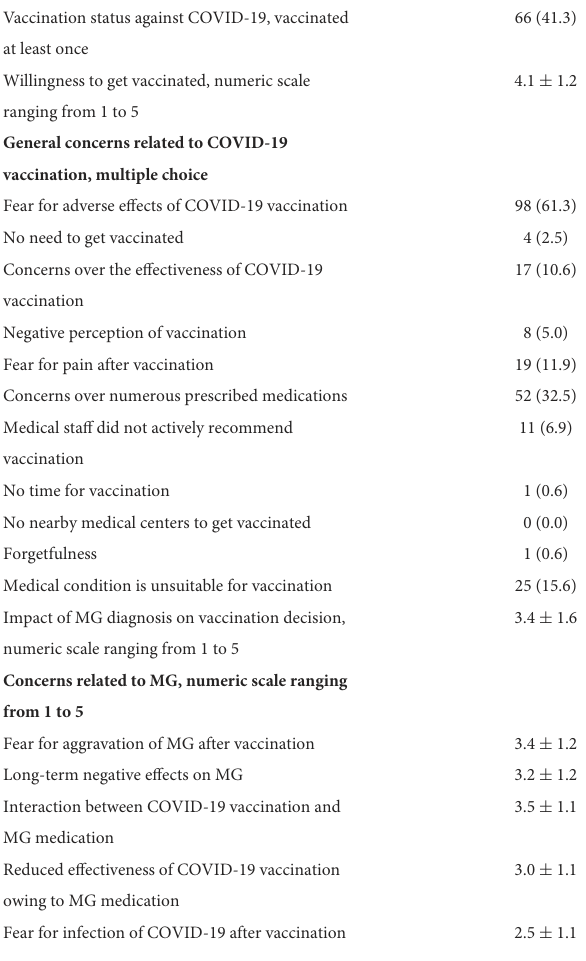
TABLE 1 Results of the questionnaire survey of 160 patients with myasthenia gravis. Total ( n =